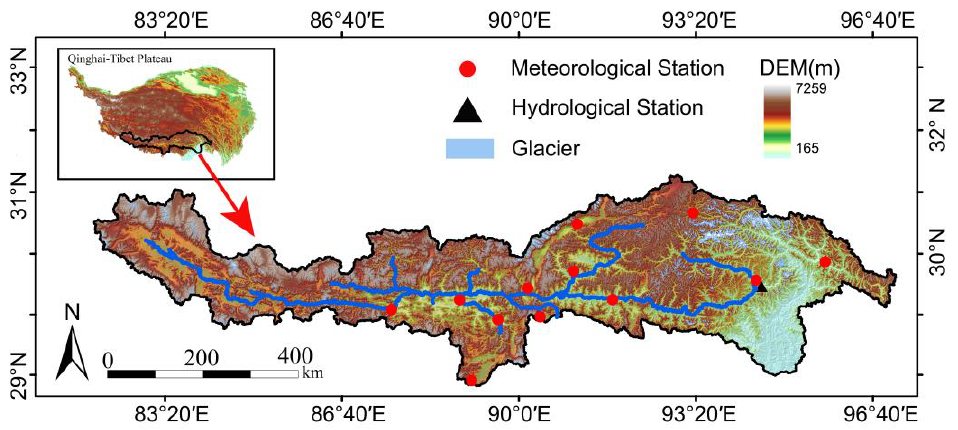
Figure 1. Location of the Yarlung Zangbo River Basin.